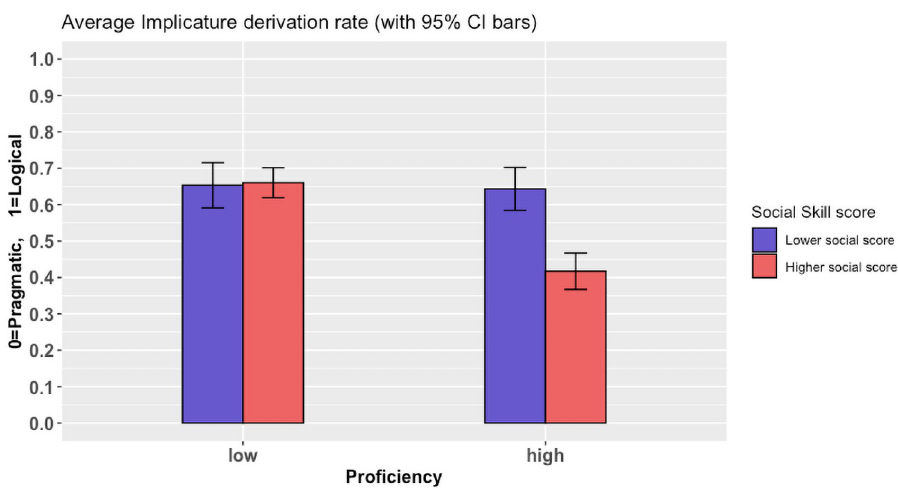
Fig 4. Interaction between proficiency and social-skill on the derivation of scalar inferences. Social-skill is dichotomized for illustration purposes only.